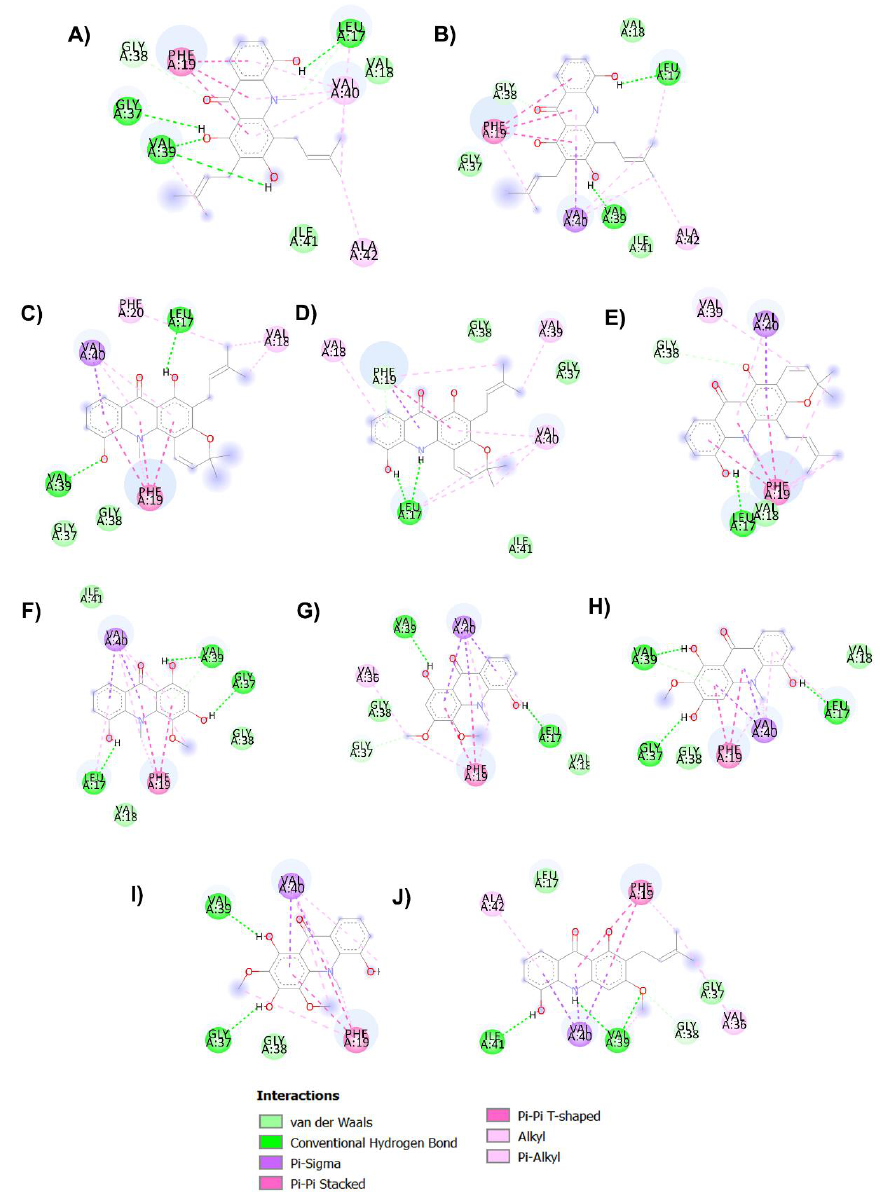
Figure 6. Binding interaction diagram of acridones N -methylatalaphylline ( A ), atalaphylline ( B ), N -methylatalaphyllinine ( C ), atalaphyllinine ( D ), N -methylcycloatalaphylline A ( E ), citrusinine II ( F ), citrusinine I ( G ), glycosparvarine ( H ), citruscridone ( I ), and buxifoliadine C ( J ) and A β 1-42